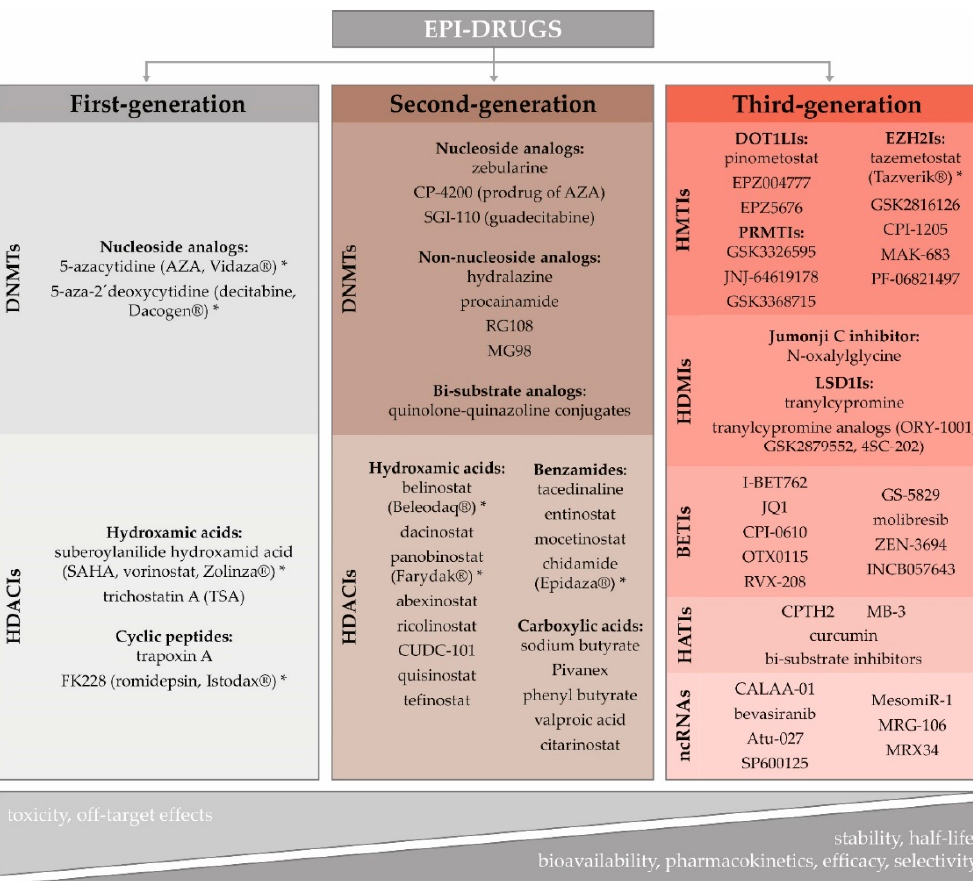
Figure 1. Different categories of epi-drugs, assessed in preclinical studies and clinical trials. Eight of them (indicated by asterisks) were approved to treat several human malignancies (modified from 7,119,120). Abbreviations: DNMTIs-DNA methyltransferase inhibitors; HDACIs-histone deacetylase inhibitors; HMTIs-histone methyltransferase inhibitors; HDMIs-histone demethylase inhibitors; BETIs-bromodomain and extra-terminal domain inhibitors; HATIs-histone acetyltransferase inhibitors; ncRNAs-non-coding RNAs; DOT1LIs-DOT1-like histone lysine methyltransferase inhibitors; EZH2Is-enhancer of zeste homolog 2 inhibitors; PRMTIs-protein arginine methyltransferase inhibitor; LSD1Is-lysine-specific histone demethylase 1A